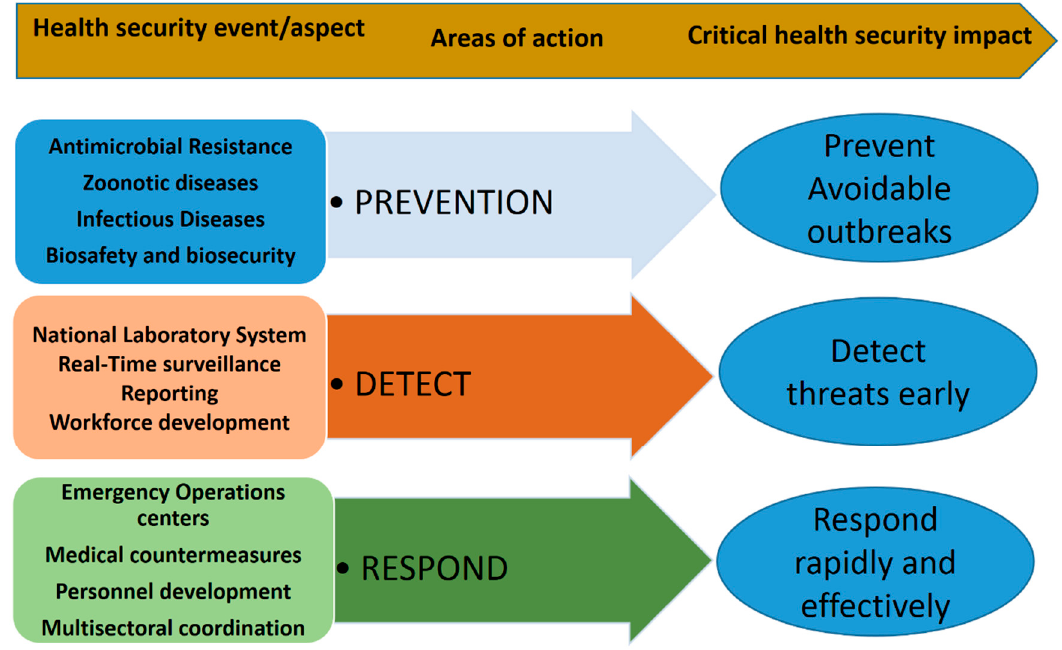
Figure 3. Blockchain application in surveillance systems in managing health threats.